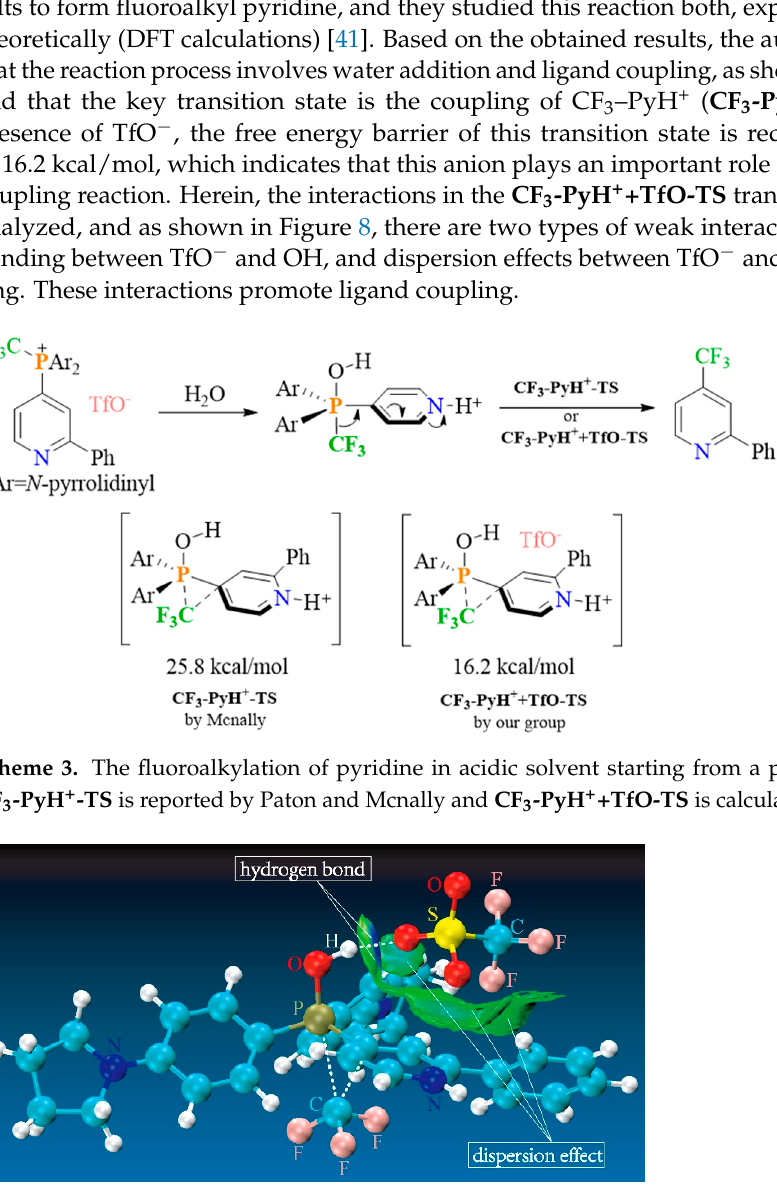
Figure 8. The weak interactions in the CF 3 ‐ PyH + +TfO ‐ TS transition state.